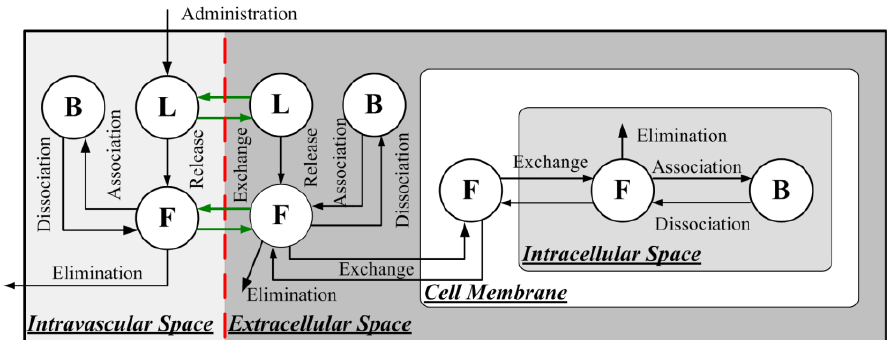
Figure 2. Drug transport in liposome-mediated delivery combined with FUS-MB-induced BBBD. The red dashed line refers to the disrupted BBB, and the enhanced transvascular transport is highlighted in green.